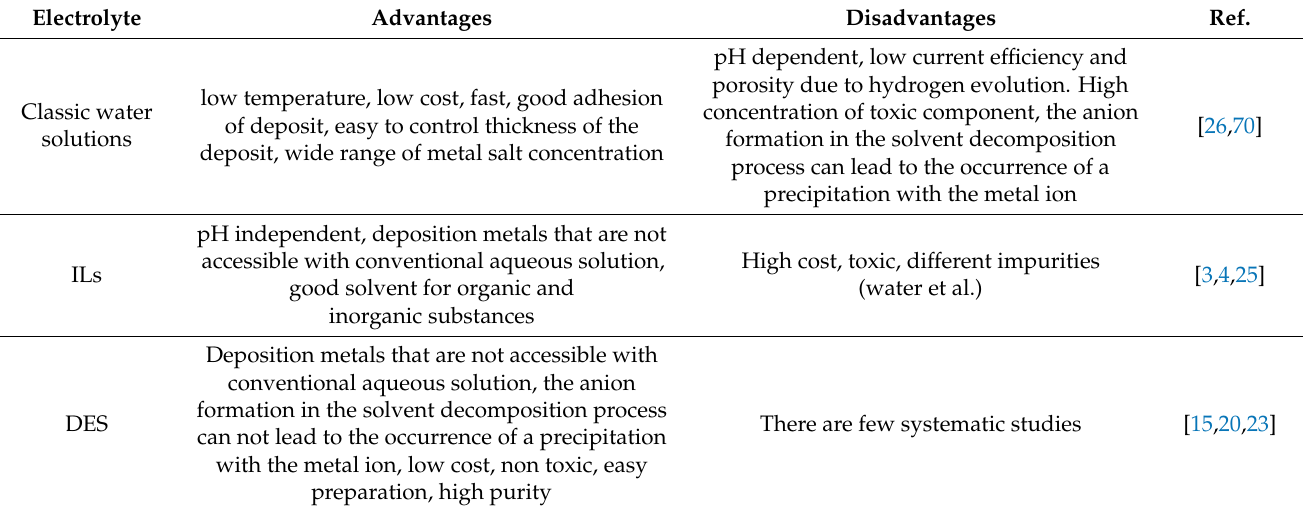
Table 3. Main advantages and disadvantages of classic (water) and modern electrolytes for electrode-